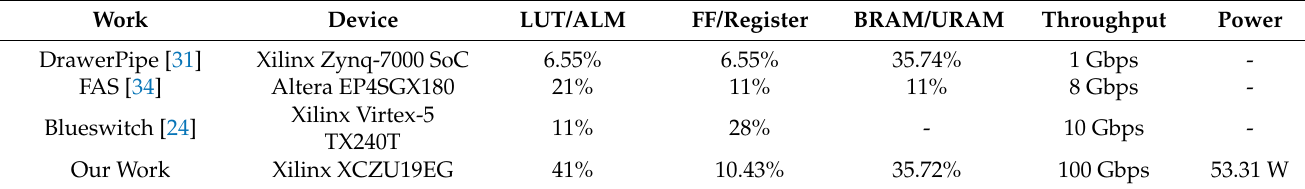
Table 3. The resource